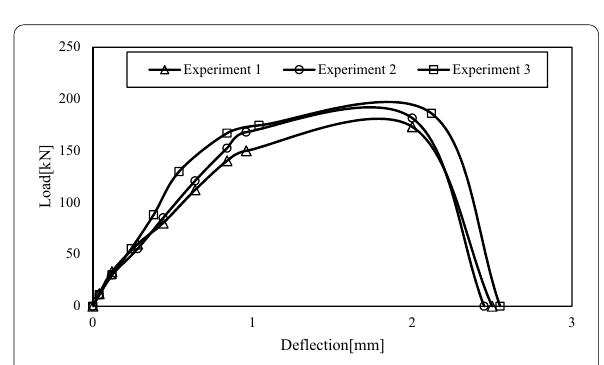
Fig. 14 Load–deflection diagram of the sleeper-excluded